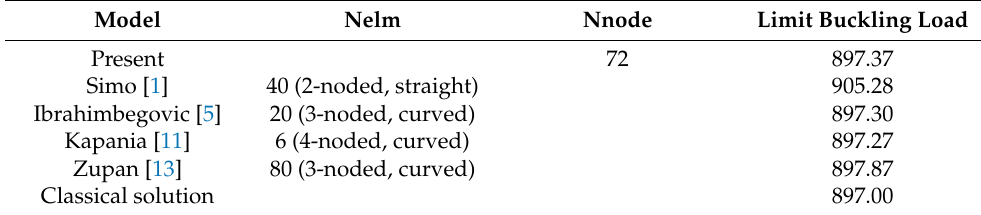
Figure 15. Load versus displacement curves for the clamped–hinged circular arch: with a downward concentrated load. Table 2. Buckling load of clamped-hinged circular arch.